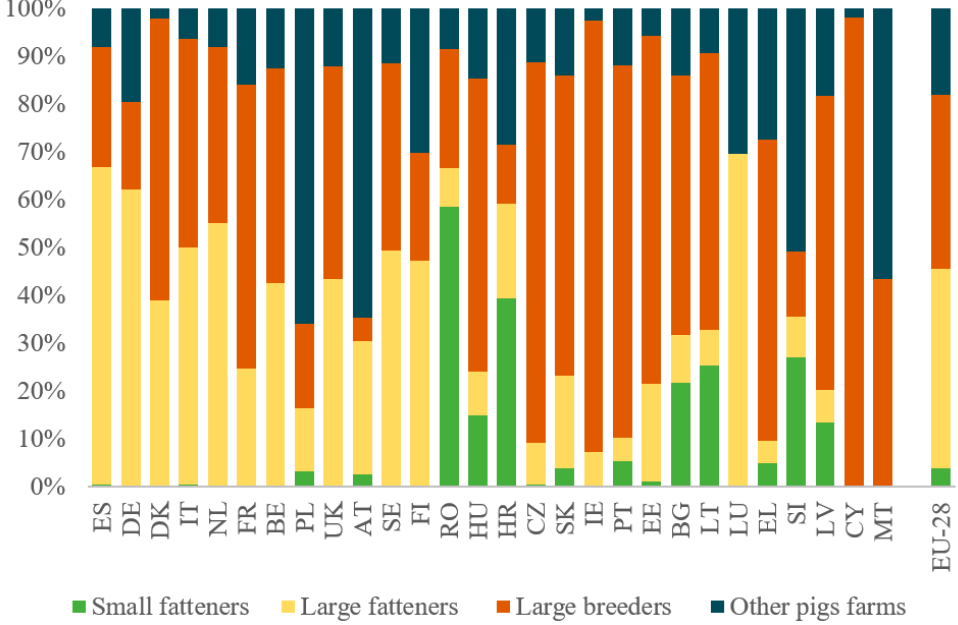
Figure 1. Distribution of pigs by the type of pig farm in the EU in 2014. Source [36].